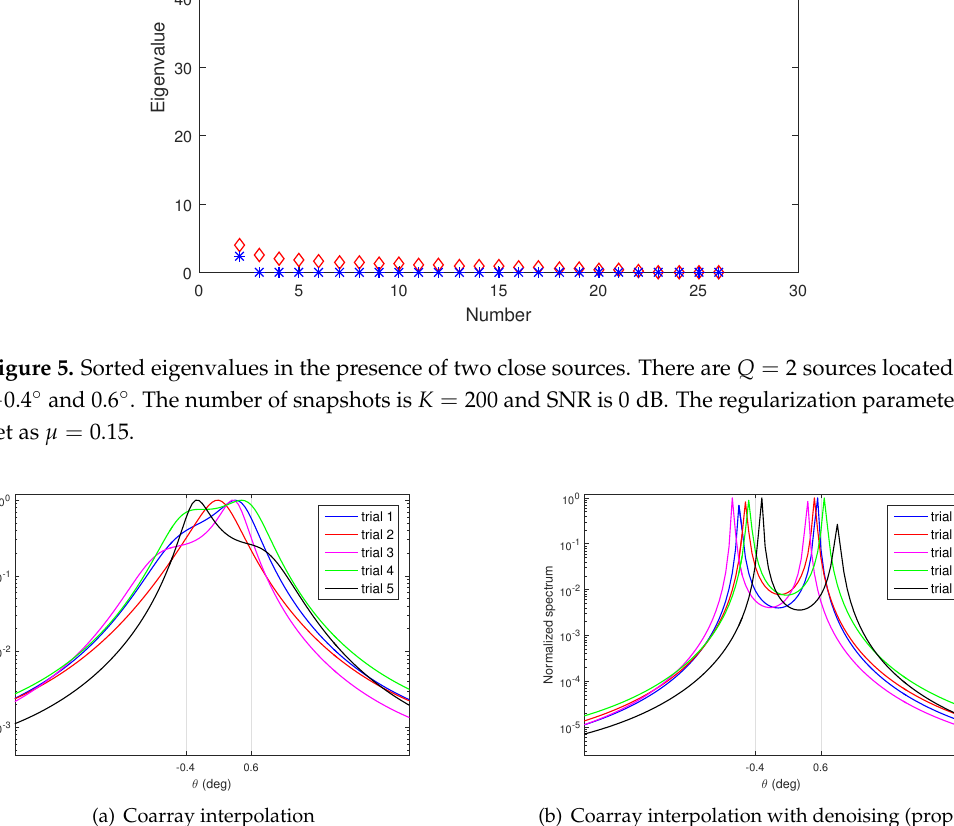
Figure 6. Spectrum for two close sources. There are Q = 2 sources located on − 0.4 ◦ and 0.6 ◦ . The number of snapshots is K = 200, and SNR is 0 dB. The regularization parameter is set as µ = 0.15. ( a ) Use of only coarray interpolation [20]; ( b ) Use coarray interpolation followed by denoising